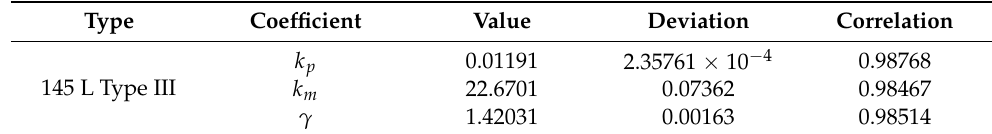
Table 5. Results of multiple parameters